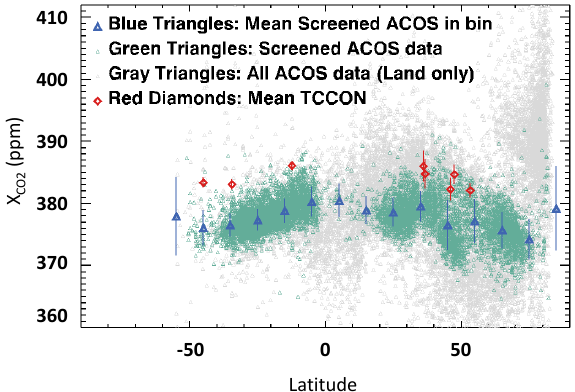
Fig. 1. All converged, cloud-free ACOS GOSAT B2.8 X CO trievals for soundings acquired over land at solar zenith angles < 85 ◦ during July 2009 (grey triangles) are compared to TCCON retrievals from that month (red diamonds). ACOS GOSAT soundings that also pass a series of post-processing filters (see text) are over-plotted as green triangles. These screened values have been averaged over 10 ◦ wide zonal bands to derive the zonal mean estimates of X CO (blue triangles with 1- σ error bars). The TCCON results are from the stations listed in Table